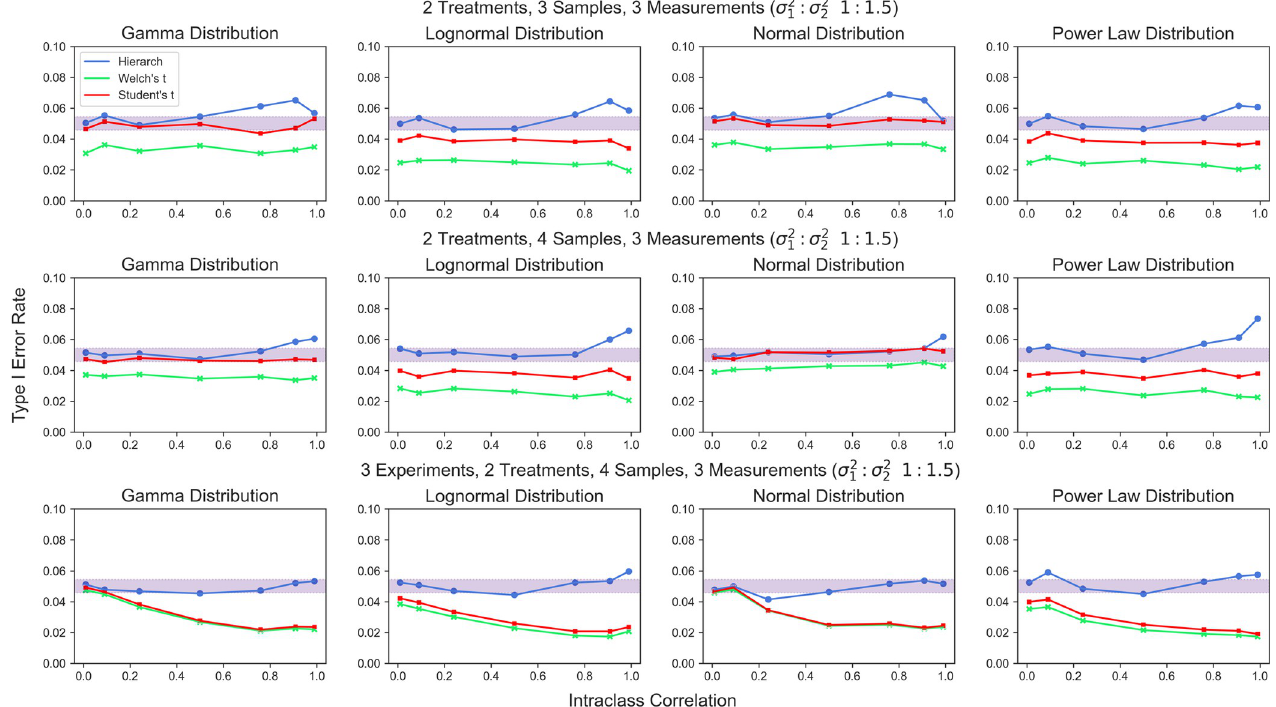
Fig 10. Type I error rate for hierarchical randomization test based on the t statistic, Welch’s t test, and Student’s t test given unequal between-cluster variance. Shaded area represents the 95% binomial confidence interval around a 5% type I error rate.